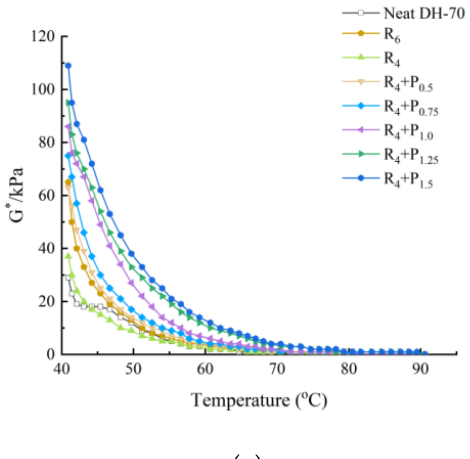
Figure 2. High-temperature properties of compound ratio of PPA – SBS and LH – 90# neat asphalt: ( a ) Complex modulus-temperature results; ( b ) Phase angle-temperature results; ( c ) G*/sinδ -tenper- ature results.